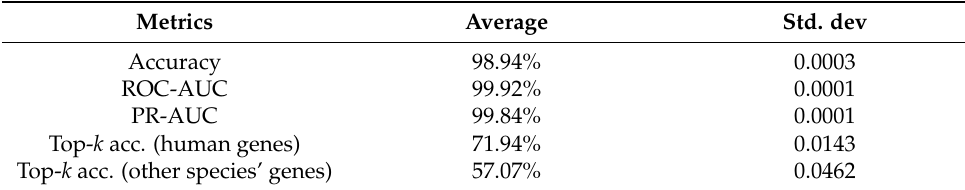
Table 4. Performance metrics of Deep Splicer.